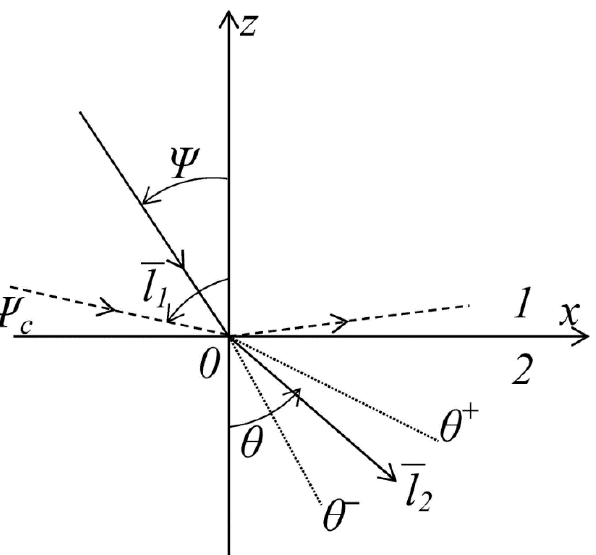
Figure 3. Diagram of a model presenting the crack passing through the layer interface. The crack trajectory (Material 1) is curvilinear in a real medium, and it fluctuates near the x axis. The average time of the layer fracture depends on the crack length. The minimum time of the layer fracture will be obtained for a crack rectilinear in average, and this is the lowest estimate of the crack resistance of the layer. The maximum time of crack resistance will be obtained in the case when the crack trajectory significantly deflects from the straight line (for example, it is a fractal curve with a dimension over 1). As is known, the crack propagation is the process of transformation of the deformation energy into the bond-breaking power, i.e., the formation of a free surface [31]. Thus, the crack trajectory is a line (surface), with a density vector of the elastic energy flux (Umov–Poynting vector) that is directed along it. The optical–mechanical analogy can be applied here. Let us consider the transmission of energy through the layer interface, namely, a change in